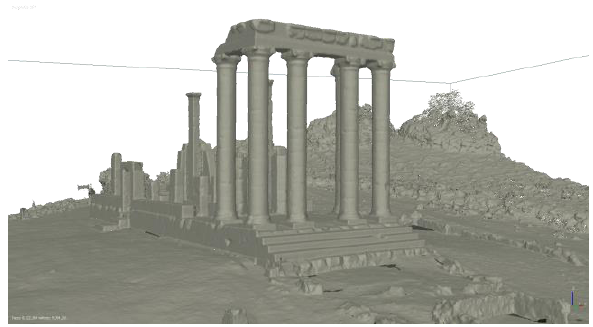
Figure 8. 3D mesh model